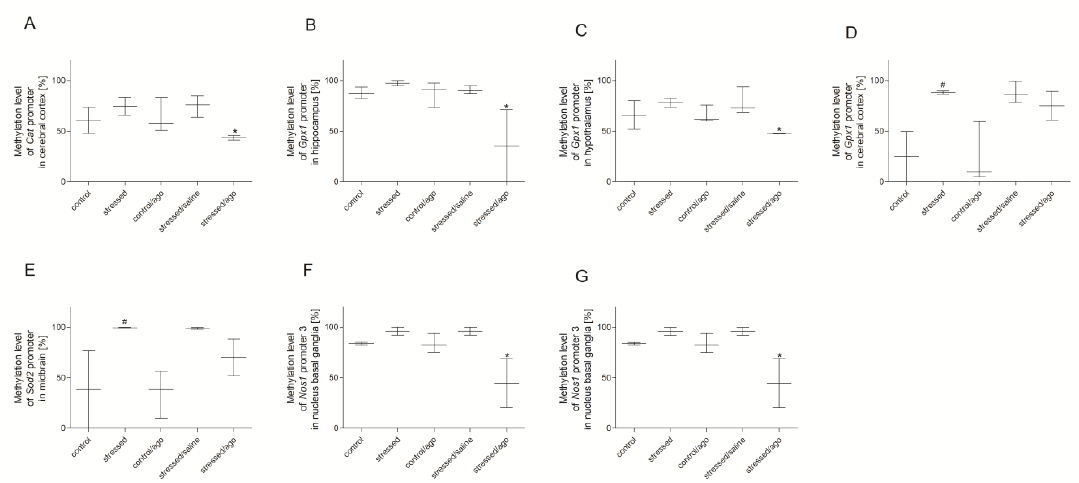
Figure 4. The methylation status of CAT promoter in cerebral cortex ( A ), Gpx1 promoter in hippocampus ( B ), hypothalamus ( C ), and cerebral cortex ( D ), SOD2 promoter in midbrain ( E ), NOS1 promoter 3 in ( F ) and amygdala ( G ) of animals exposed to CMS procedure for two weeks (Control, Stressed) and in animals exposed to CMS procedure for seven weeks and administered vehicle (1 mL/kg) or agomelatine (10 mg/kg) for five weeks (Control/Ago, Stressed/Saline, Stressed/Ago). Data presented as means ± SEM. N = 6. * p < 0.05 for differences between stressed and stressed/ago groups, and # p < 0.05 for differences between controls and stressed groups.